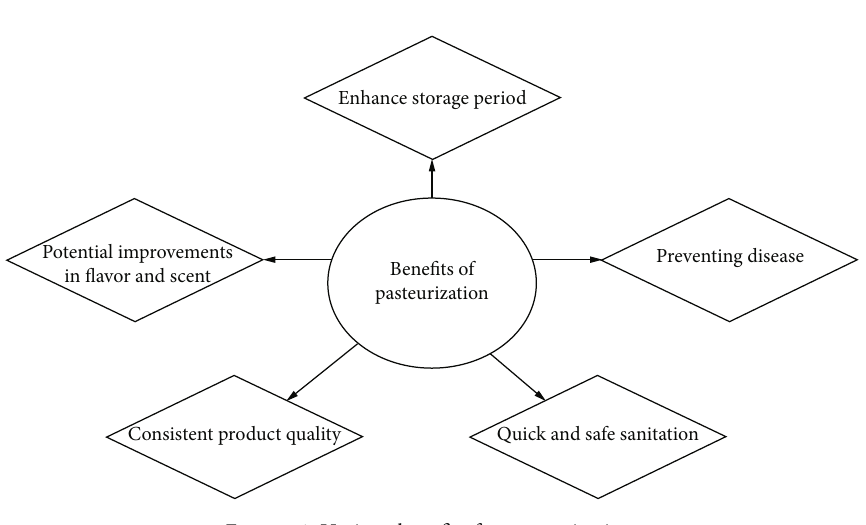
Figure 4: Various bene fi ts for